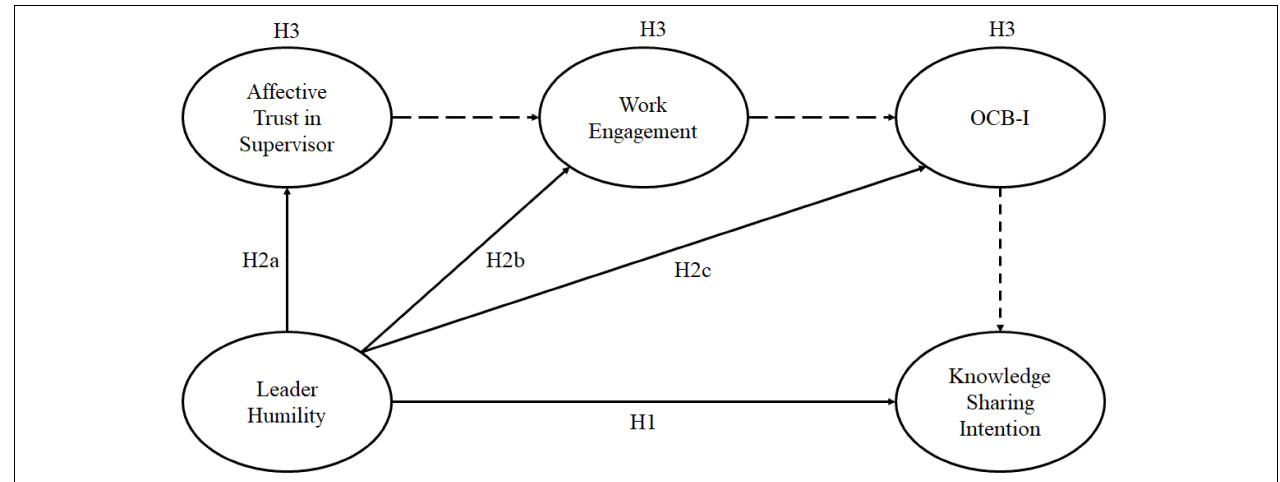
FIGURE 1 | Proposed research model. Dotted lines indicated mediation hypotheses 3a, 3b, and